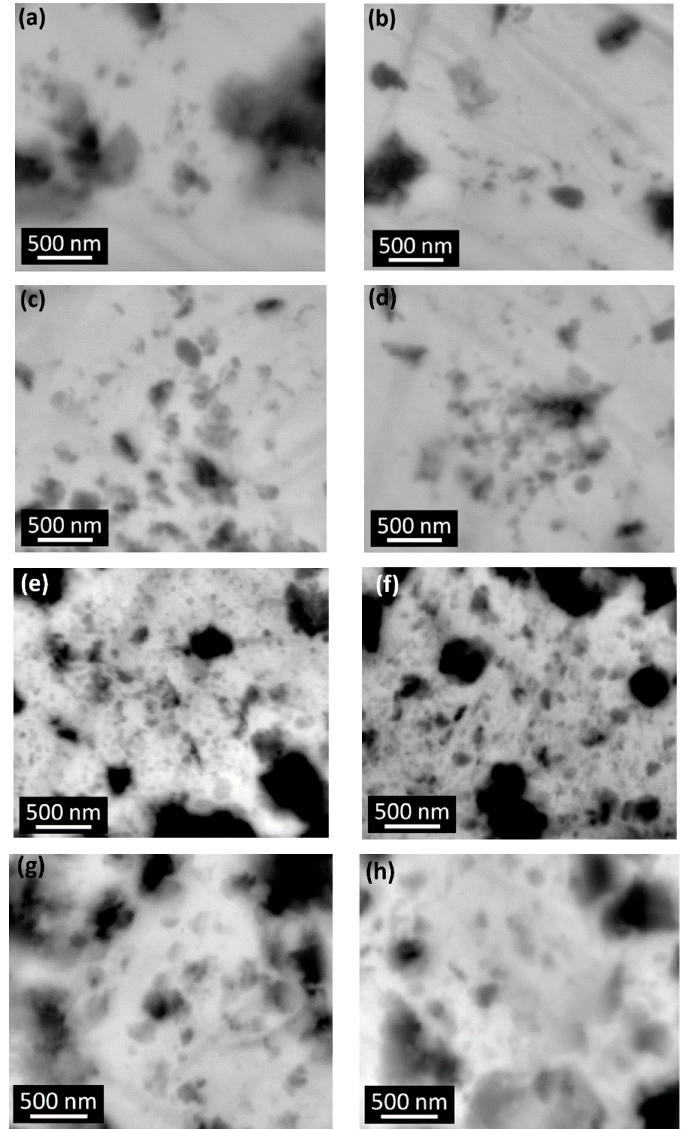
Figure 12. SEM BSE images of the cross-sections of selected Zn–SiC layers formed by either DCD ( a , c , e , g ) or PED ( b , d , f , h ), with ( c – h ) or without ( a , b ) organic bath additives. ( a ) 1.8 wt.% SiC, FE = 93.1%,